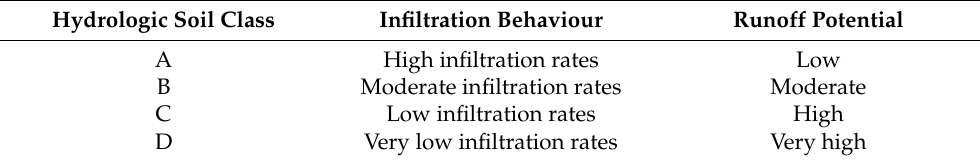
Table 1. Hydrologic soil classes with corresponding infiltration behaviours and runoff potential. Hydrologic Soil